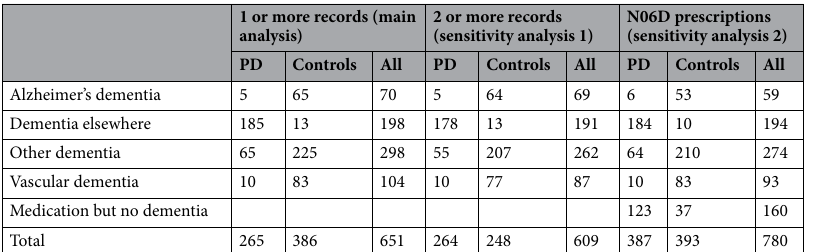
1 or more records (main